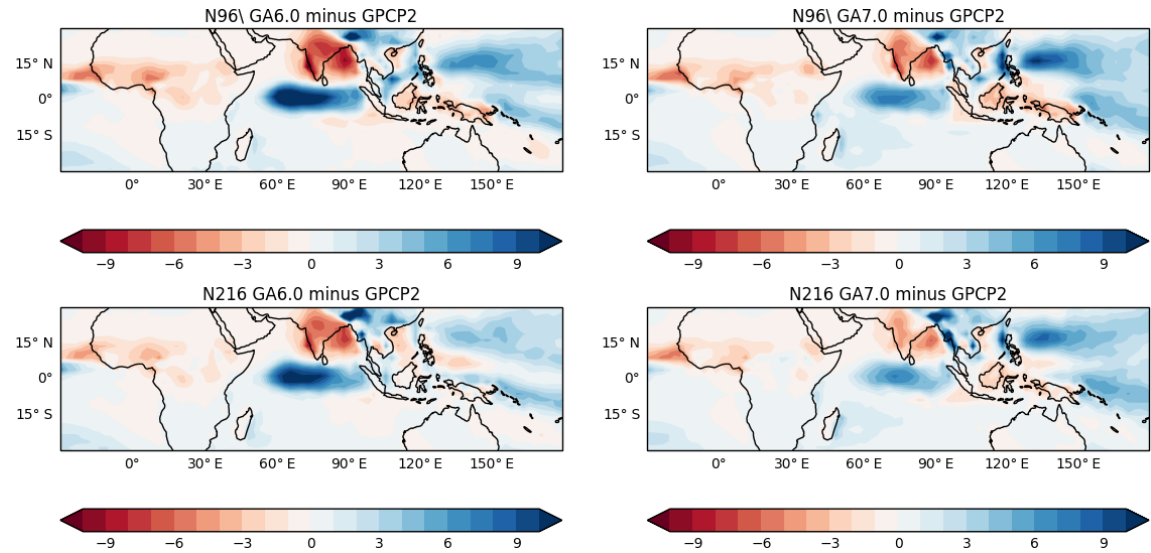
Figure 18. JJA precipitation rate biases versus GPCP over the Indian Ocean and the maritime continent (mmday − 1 ) from 27-year N96 and N216 atmosphere/land-only climate simulations of GA6.0 and GA7.0. The layout is the same as in Fig.